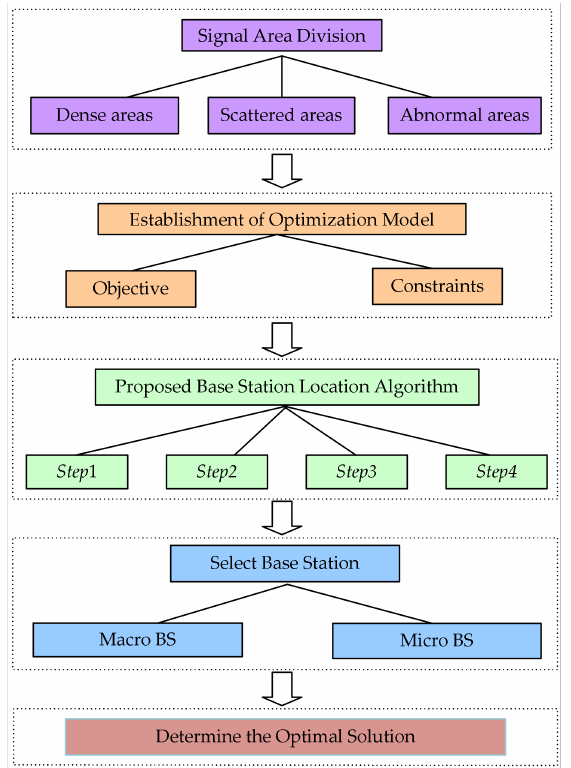
Figure 3. Schematic diagram of the system model used in this